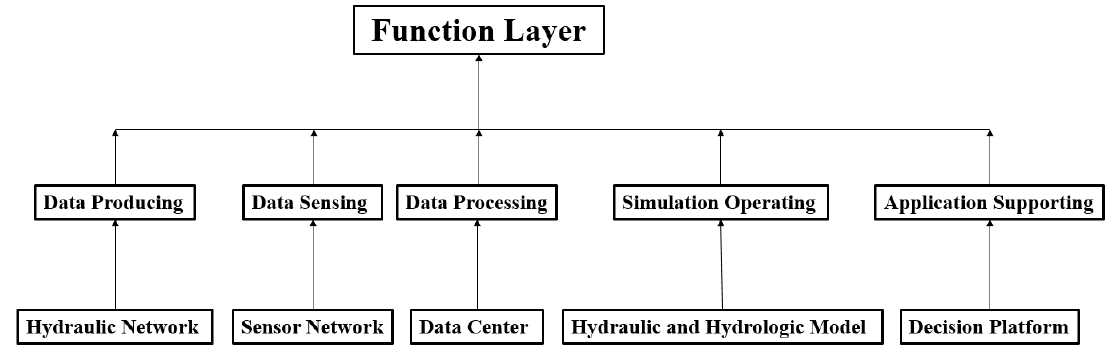
Figure 8. Function layer designing.